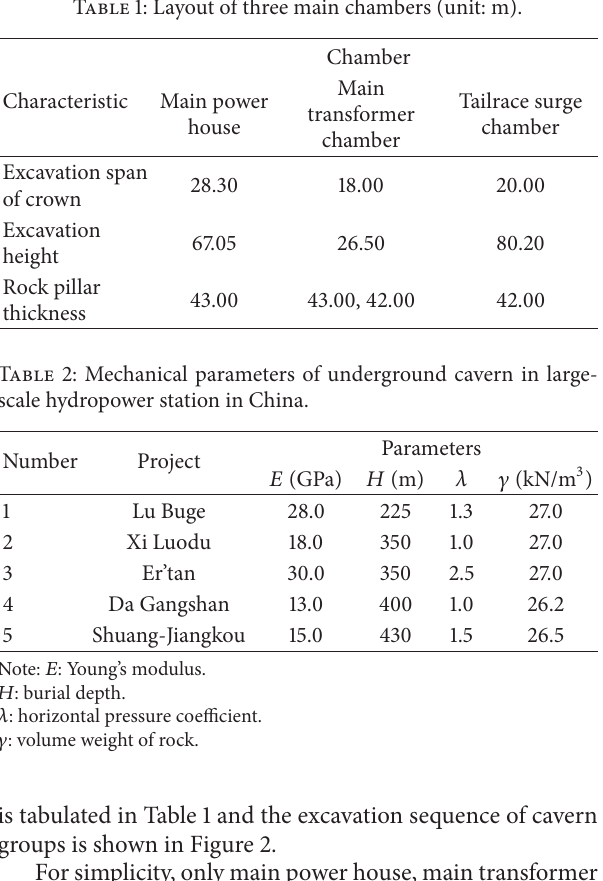
Table 1: Layout of three main chambers (unit: m).